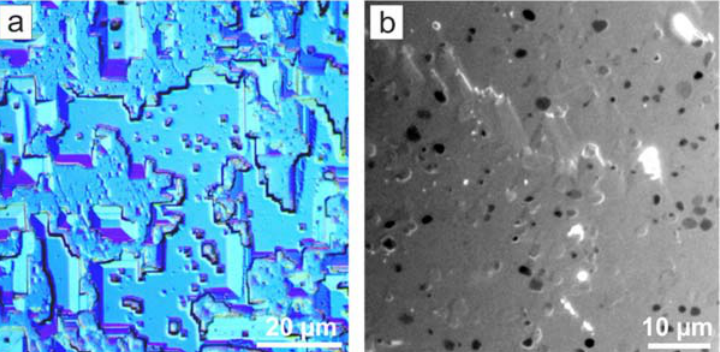
Figure 4. Optical micrographs of fragments of overgrown diamond layers on seed crystals: ( a ) {100} face (run ES-10, DIC metod); ( b ) inclusions of graphite (black) in overgrown diamond layers (run ES-3, transmitted light).